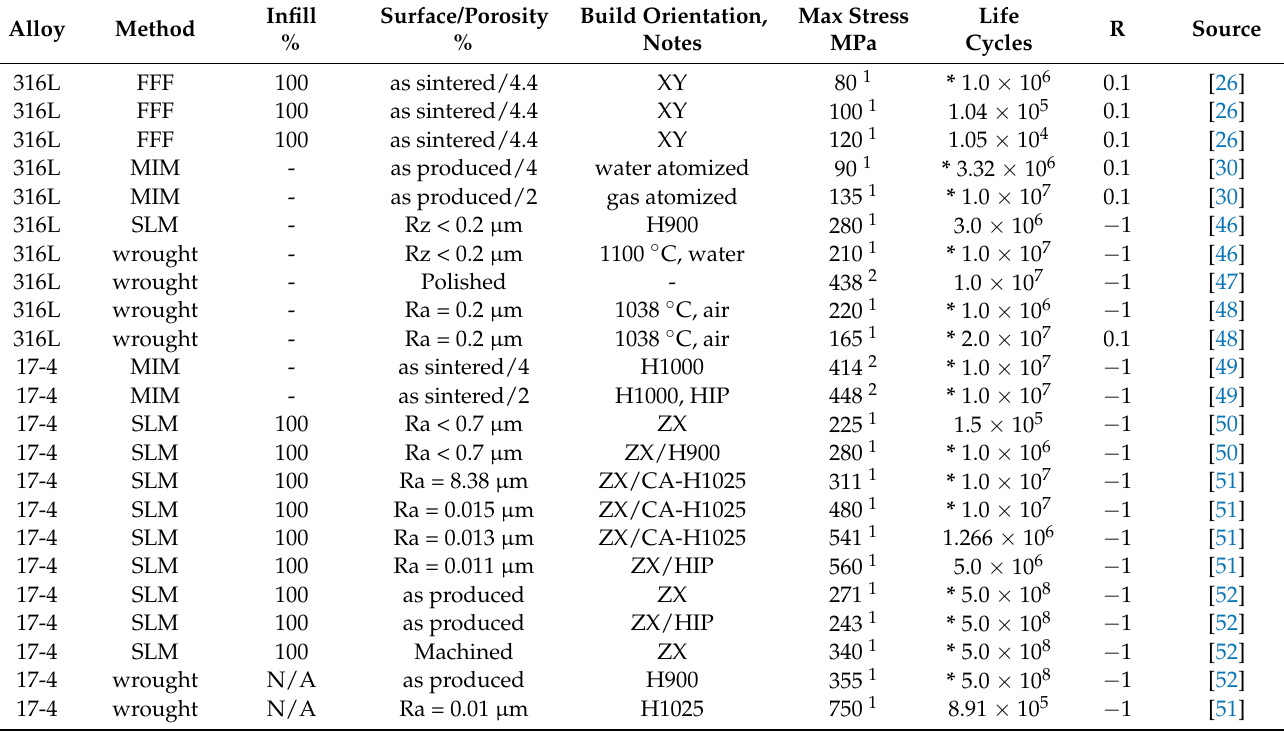
Table 12. Overview of high cycle fatigue properties for 316L and 17-4 PH stainless